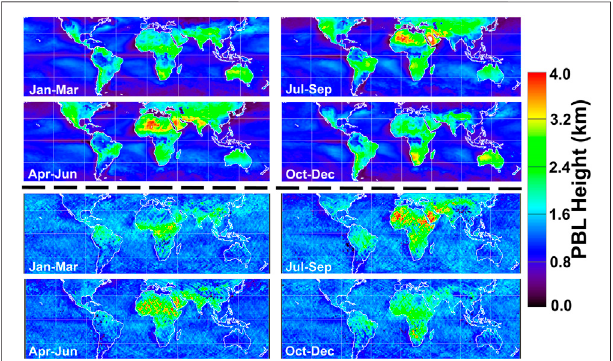
FIGURE11| MERRA-22016seasonalplotsofPBLheightat14:00local time (upper 4 plots) between 51S and 51N latitude and CATS average seasonal PBL height derived from all 2016 nighttime granules using the CNN algorithm (lower 4